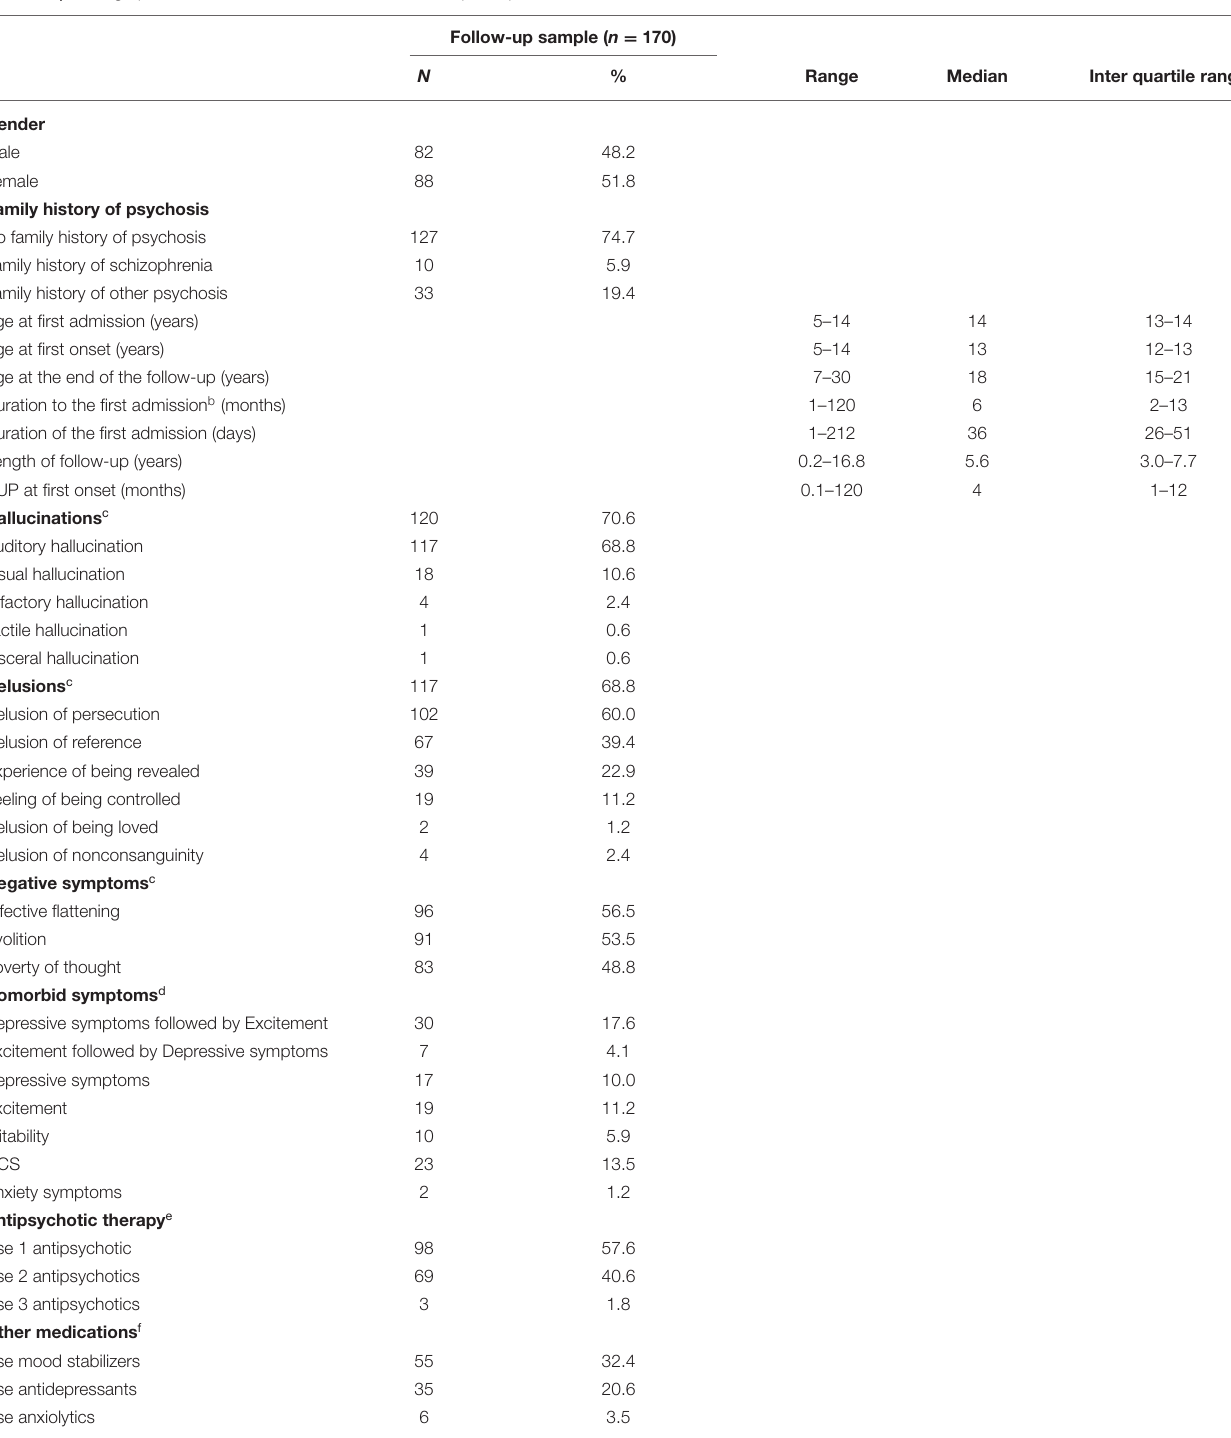
TABLE 2 | Demographics and clinical characteristics of follow-up sample a